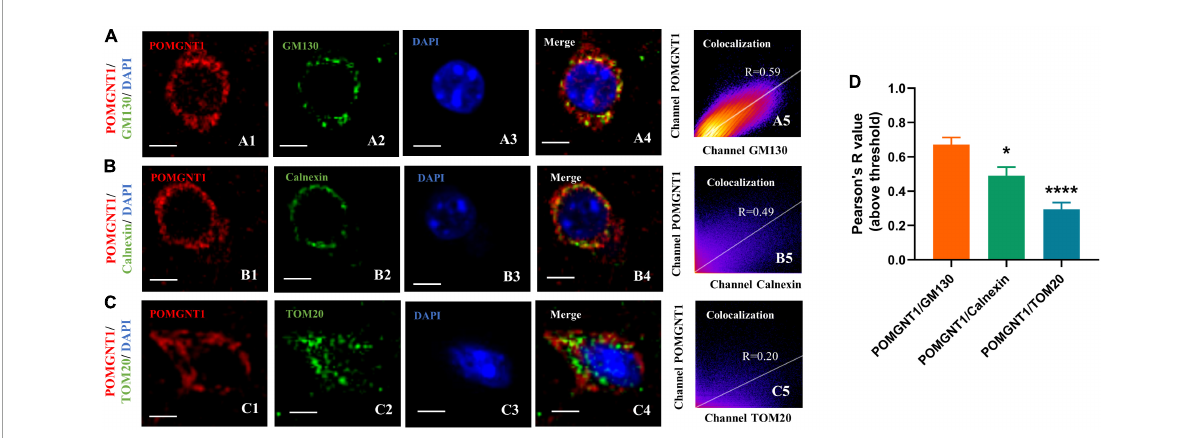
FIGURE5 Subcellular localization of POMGNT1. (A–C) Dual immunostaining of POMGNT1 (red) and organelle-specific markers (green) in the coronal brain sections of the cerebral cortex. Merge images show their colocalization (yellow). Immunofluorescence imaging showing POMGNT1 co-localized with GM130 (Golgi marker) (A) , Calnexin (endoplasmic reticulum marker) (B) , and TOM20 (mitochondria marker) (C) . Co-localization is significantly highly in Golgi. Graphs in the right panel show Pearson’s correlation coefficient score (denoted by R) between POMGNT1 and organelle-specific marker for each image (0 < R < 1; A higher R-score indicates better co-localization between POMGNT1 and the organelle-specific marker). Scale bar = 20 µ m. (D) Quantification of the Pearson’s correlation coefficient score between POMGNT1 and organelle-specific markers, GM130, Calnexin and TOM20, respectively. N = 6. Data are presented as the mean ± SEM; * P < 0.05; **** P < 0.0001 versus the POMGNT1/GM130 group (one-way